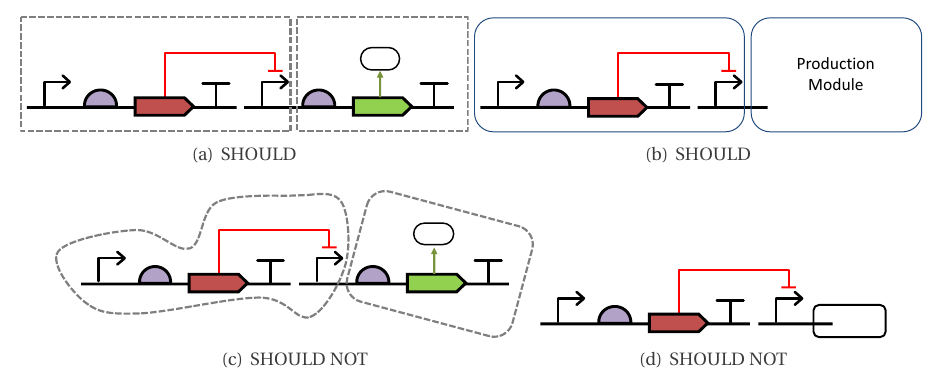
making it larger than other glyphs and with a different line style. Examples are provided in Figure 23.